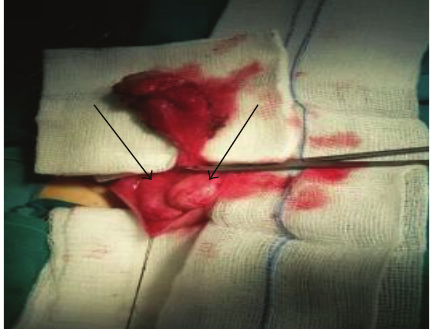
Figure 3: After the removal of the lesion, only the parietal layer of the tunica albuginea covers the testicles (arrows).